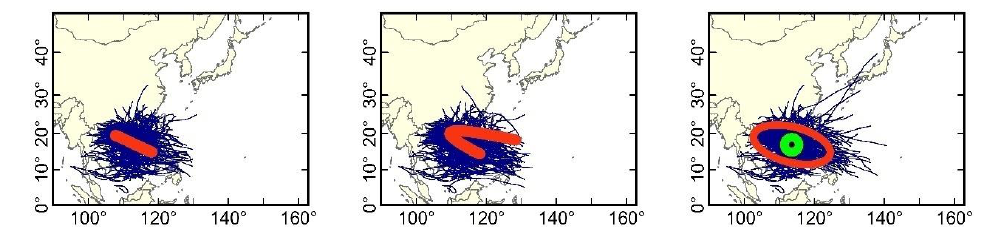
Table 2. Number of TC trajectories in the different classes and the proportion relative to the total TC